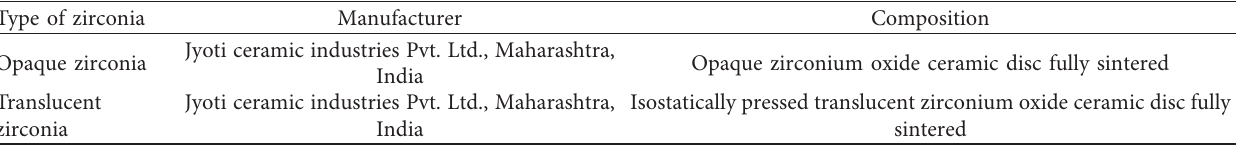
Table 1: Zirconia specimens used in the study.